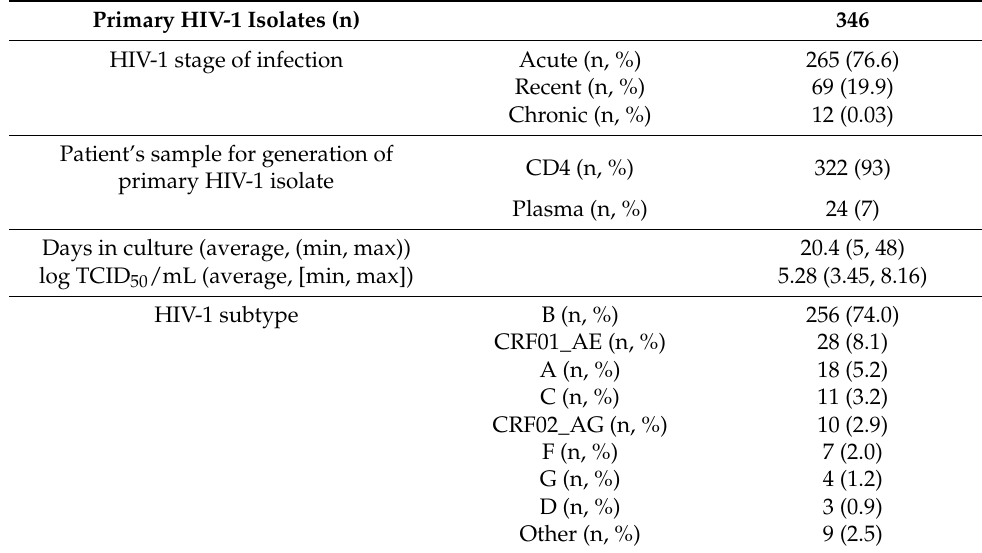
Table 1. Characteristics of primary HIV-1